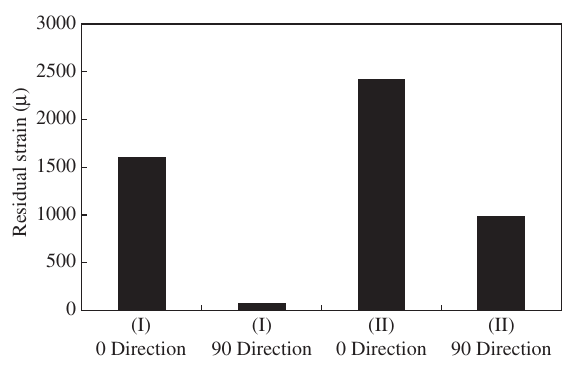
Figure 9 Measured electrical resistance changes for the two differ- ent stacking